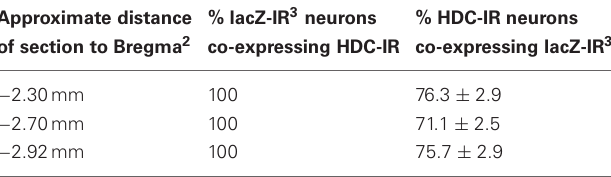
FIGURE 5 | Ammonium-induced excitation. (A) Averaged time course diagrams show normalized firing frequency (cell-attached voltage-clamp mode) in control experiments and in the presence of indicated blockers, which abolish pH 7.0-induced excitation. (B) Ouabain does not block ammonium-induced excitation.